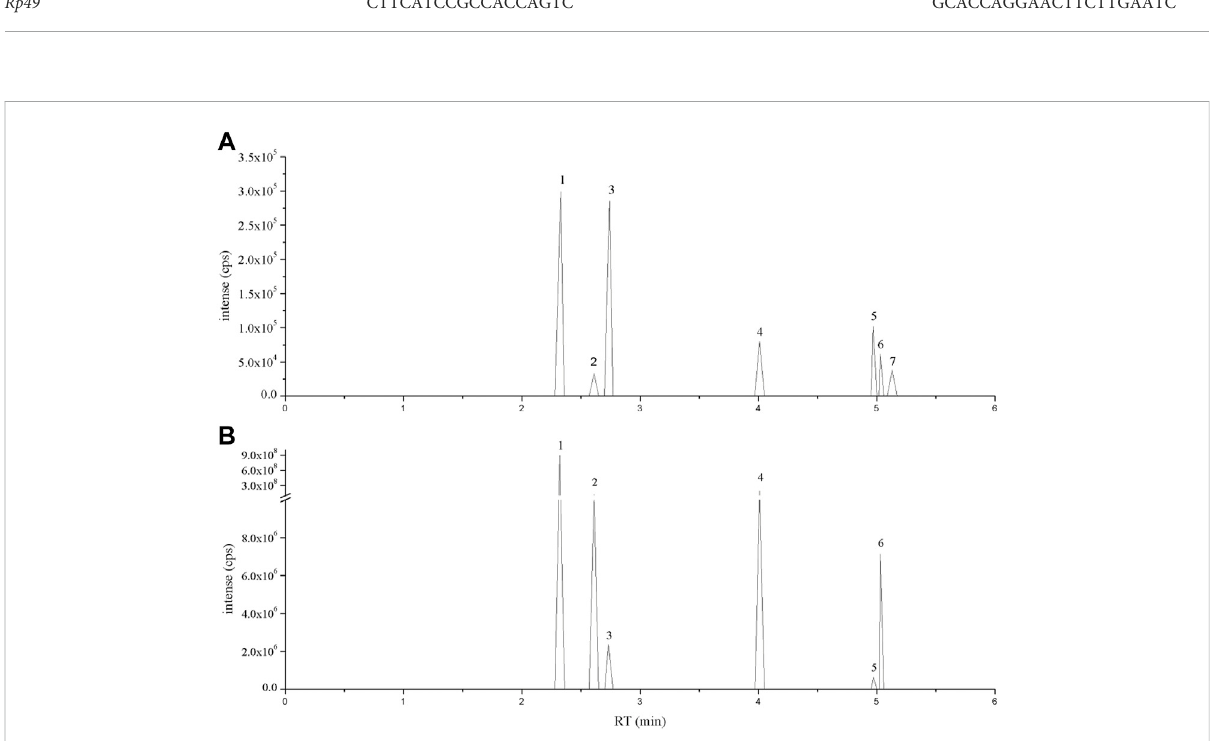
FIGURE 1 LC-MS ion- fl ow chromatogram of (A) Standard and (B) FPE. (1) Puerarin, (2) Daidzin, (3) Rutin, (4) Daidzein, (5) Apigenin, (6) Genistein and (7)